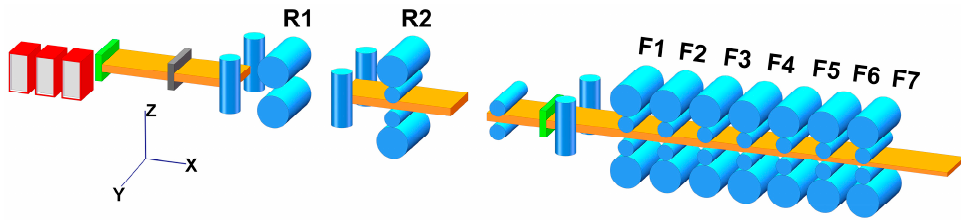
Figure 2. Schematic diagram of a 1580 mm hot-rolling production line.